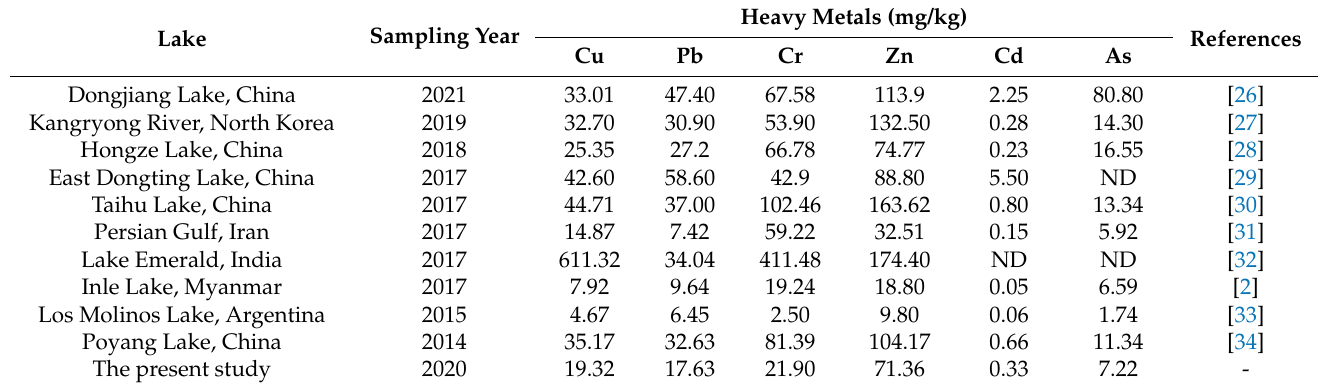
Table 2. Mean concentration of heavy metals in sediments of the lake systems following the order of sampling